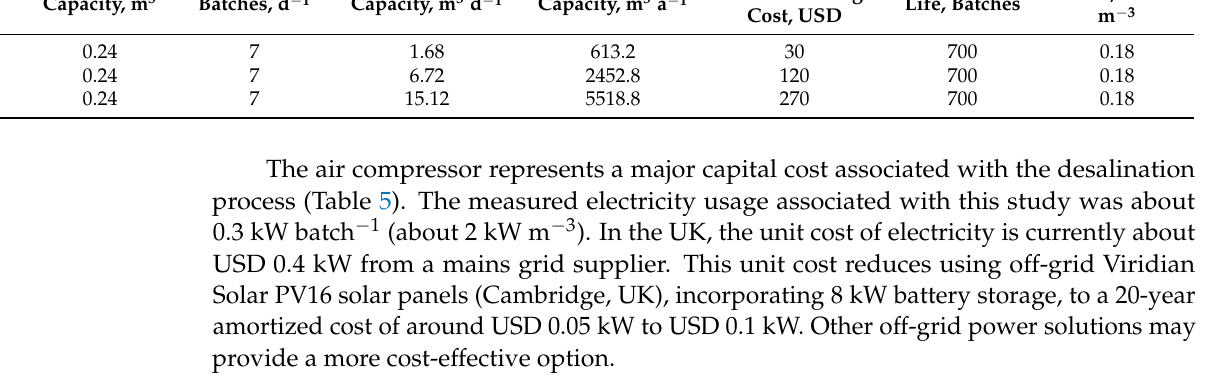
Table 5. Compressor cost based on a 1.2 kWh air compressor providing up to 222 L m − 1 . Compressor costs vary with manufacturer and